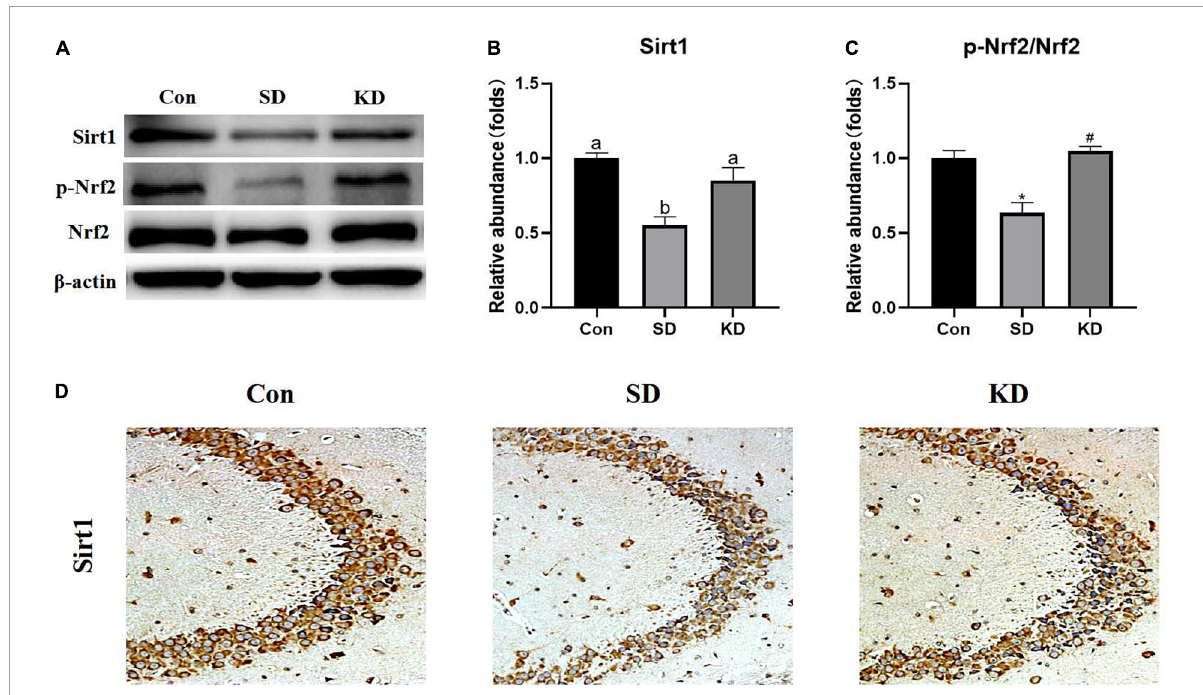
FIGURE7 Effects of ketogenic diet (KD) on Sirt1/Nrf2 signaling pathway in hippocampus induced by chronic sleep deprivation (SD). (A) Western-blots and (B,C) densitometry of Sirt1 and p-Nrf2/Nrf2. Protein levels are normalized to β -actin which served as loading control and reproduced with Sham group. Values are indicated as the mean ± SEM ( n = 7). Different letter indicates significantly different between each group ( p < 0.05); * p < 0.01, compared with Con; # p < 0.01, compared with SD. (D) Immunohistochemistry analysis of Sirt1, scale bars = 50 µ m ( n = 3).